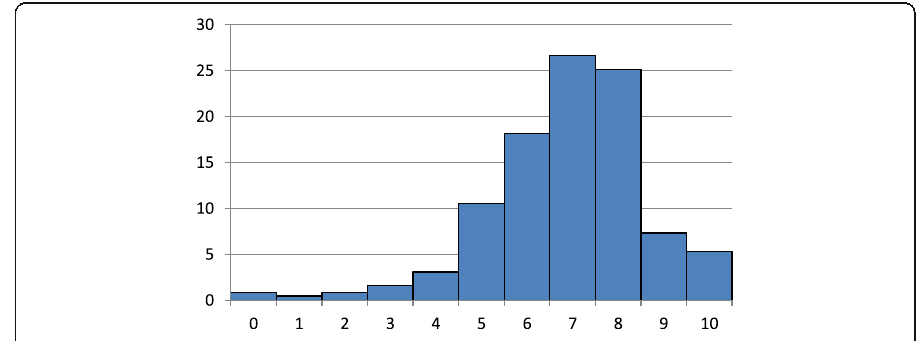
Fig. 2 Percentage distributions of individuals aged 18 – 64 according to their life